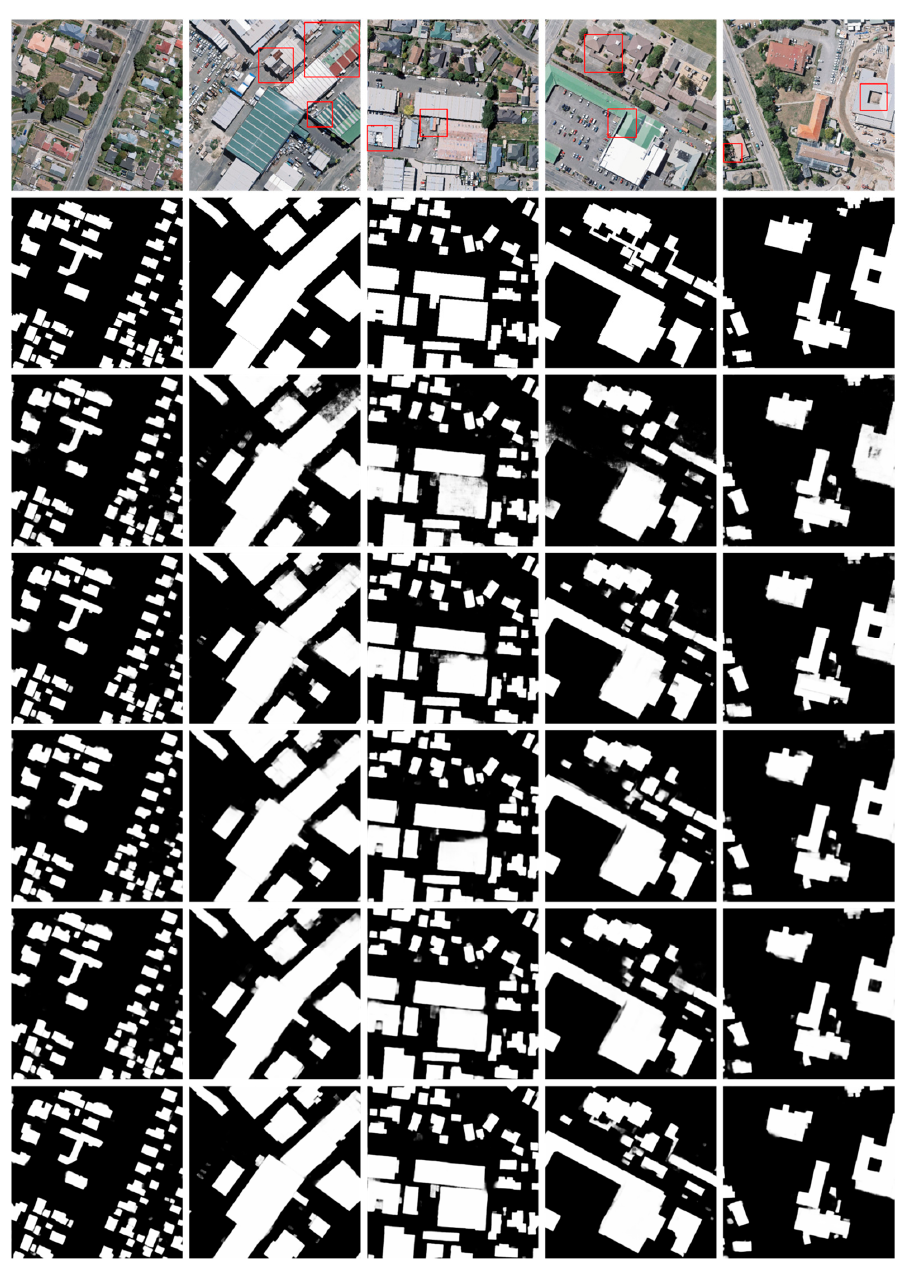
Figure 8. Building extraction results on the WHU dataset. The first two rows are images and corresponding ground truth. The rest five rows are produced by SegNet, U-Net, RefineNet, DeepLab v3+, and DE-Net.